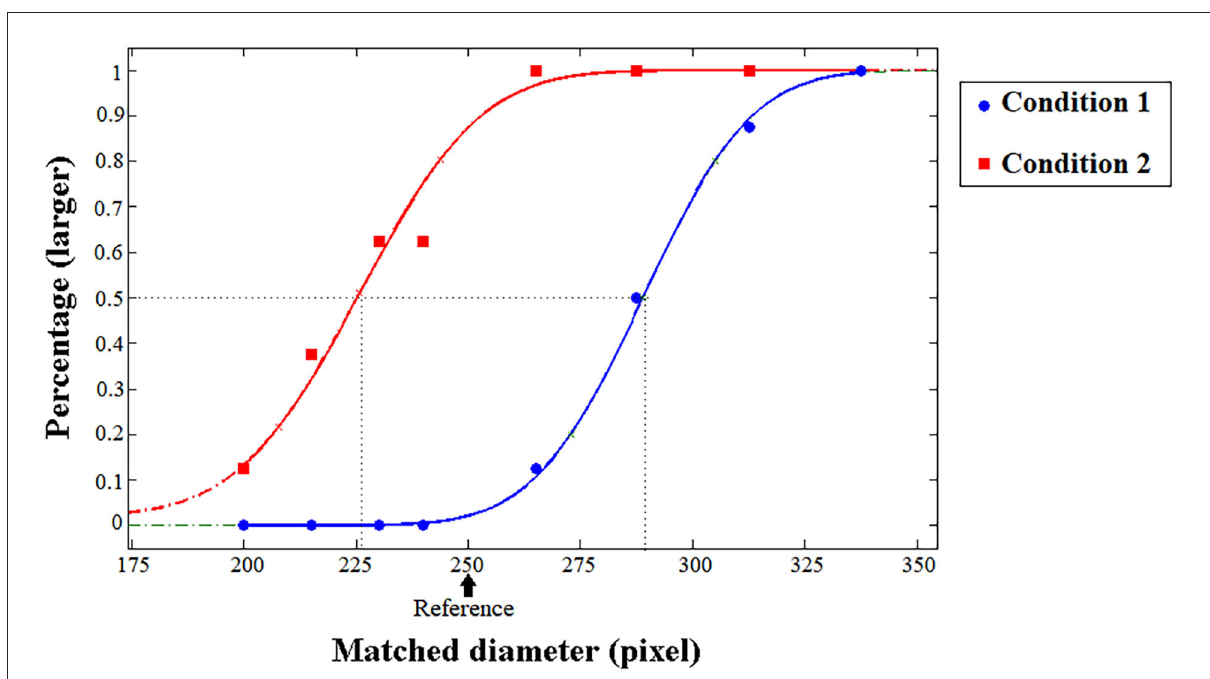
FIGURE3 Typical psychometric functions in the size task (control experiment). The proportion of trials in which the test patch appeared to be larger than the reference patch was plotted as a function of the pixel of the test patch, and the vertical dashed lines indicate the PSE. The arrow shows the reference diameter (pixel). The participants’ typical responding curves are displayed to indicate the average PSE results. The blue line represents Condition 1 (the reference was surrounded by smaller circles), while the red line represents Condition 2 (the reference was surrounded by larger